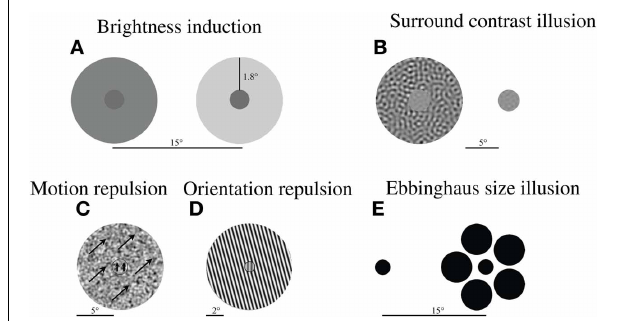
FIGURE 1 | Example stimuli in each experiment. (A) Brightness induction illusion: The reference stimulus (left) with darker surround appears brighter that the target stimulus (right) of equal luminance with lighter surround. (B) Surround contrast illusion: A stimulus with a high contrast pattern in the surround (left) appears weaker in contrast relative to the reference stimulus (right) of equal contrast. (C) Motion and (D) orientation repulsion: The motion direction or orientation of a center stimulus appears to be repelled away from the motion direction or orientation of the surrounding pattern (arrows denote motion direction). (E) Ebbinghaus size illusion: A circle appears smaller when presented with large circles in the surround (right), relative to a stimulus of equal size (left). Note: Scale bar denotes the stimulus display size in degrees of visual angle. The spacing between stimuli in 1A is not on the same scale as the size of the